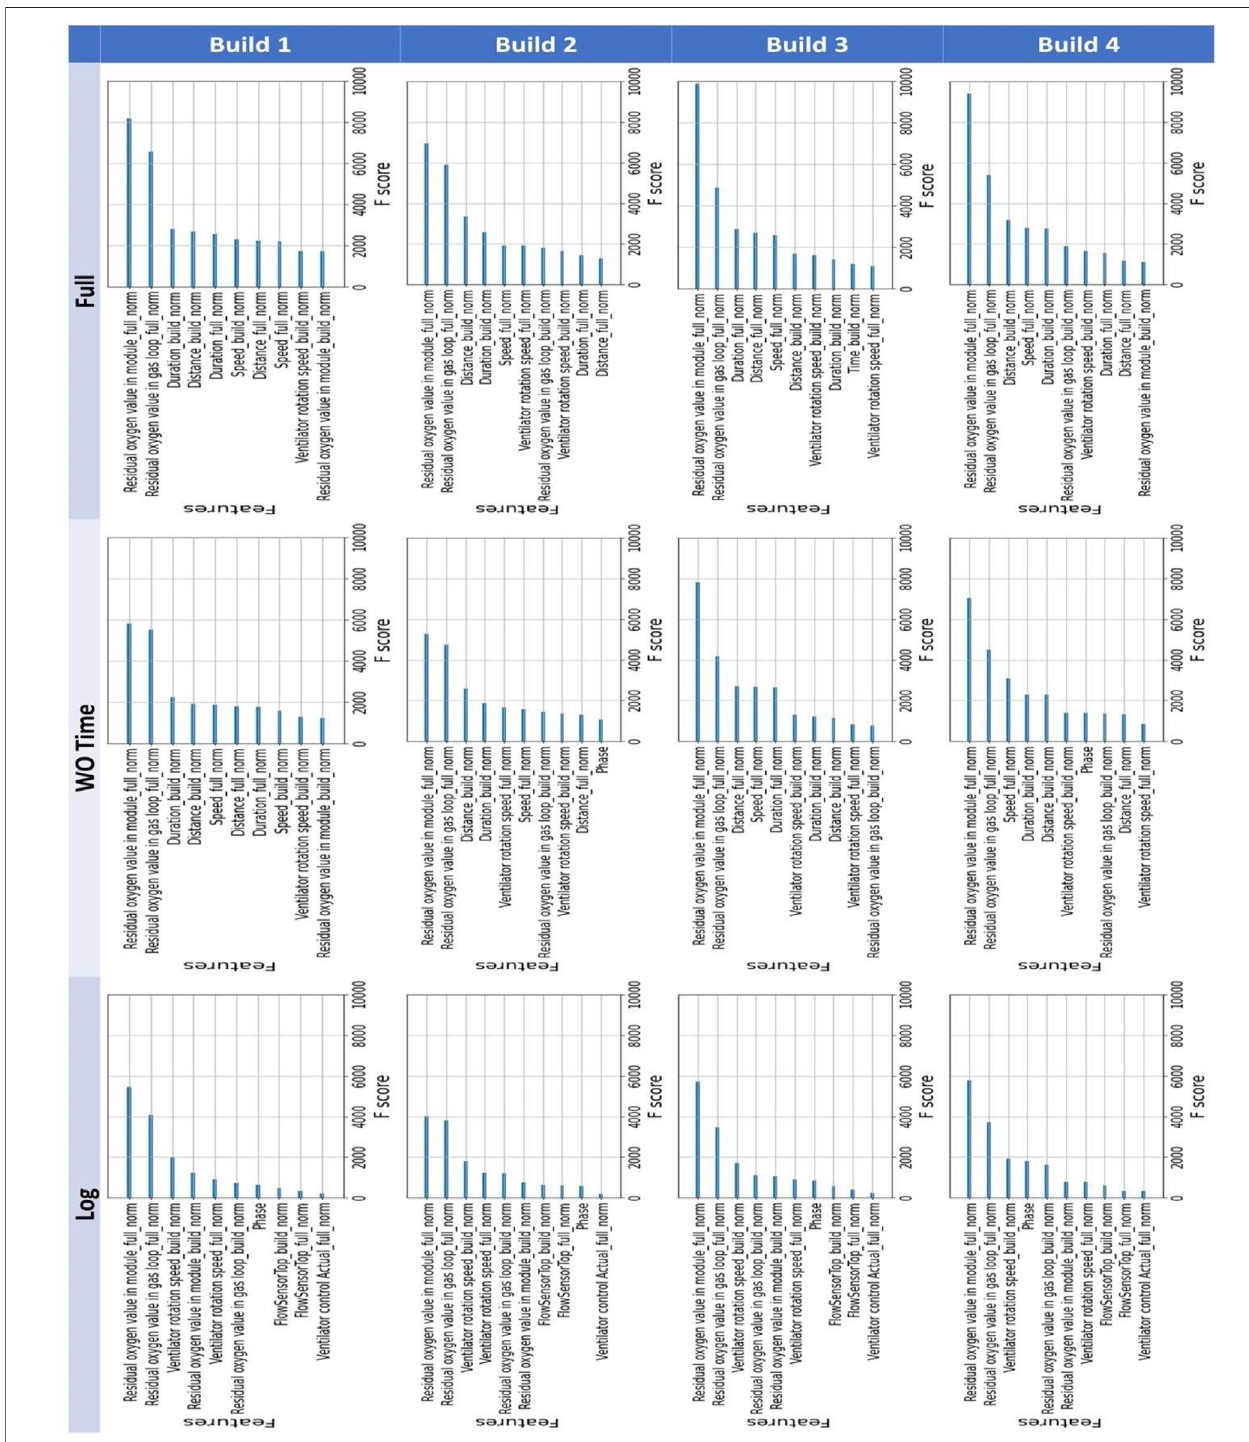
FIGURE 7 | XGBoost feature importances for the twelve build and dataset combinations.